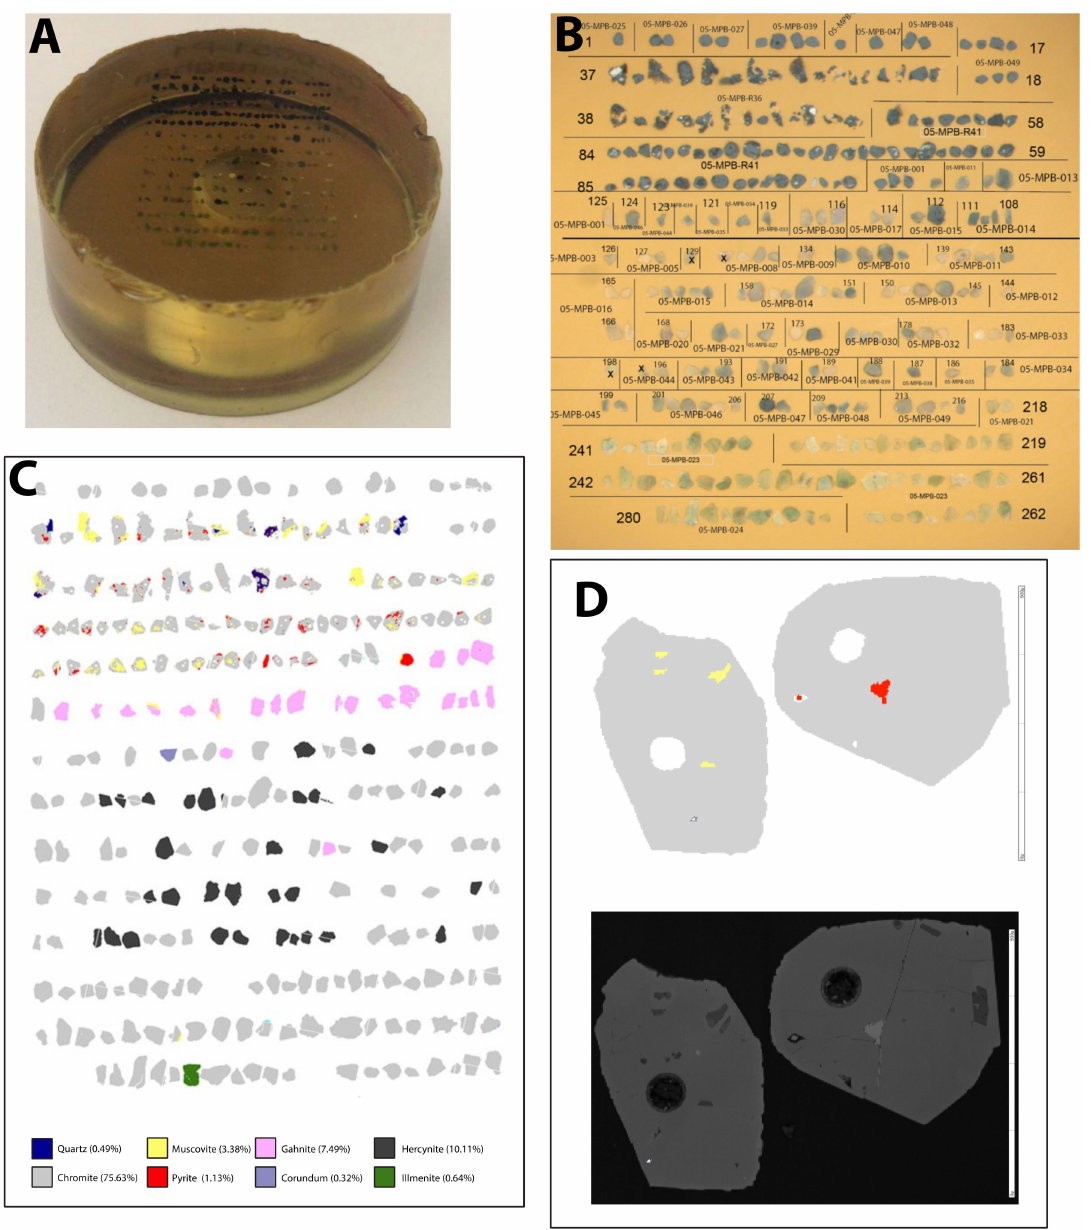
Figure 2. Example of the indicator mineral chemistry workflow from epoxy mount to laser ablation analysis. ( A ) Epoxy-mounted mineral grains after mineral separation. ( B ) Optical stereo binocular photomicrograph of polished grains in an epoxy mount; most grains 0.25–0.5 mm diameter. ( C ) False- colour processed Mineral Liberation Analysis (MLA) image of mineral grains in an epoxy mount. ( D ) MLA image (upper) of chromite grains (grey) with inclusions (red, yellow) and corresponding backscatter secondary electron image (lower); both imagesf show circular 50 µ m laser ablations spots in each grain. Scale bar is 500 µ m. Modified from Layton-Matthews et al., 2014